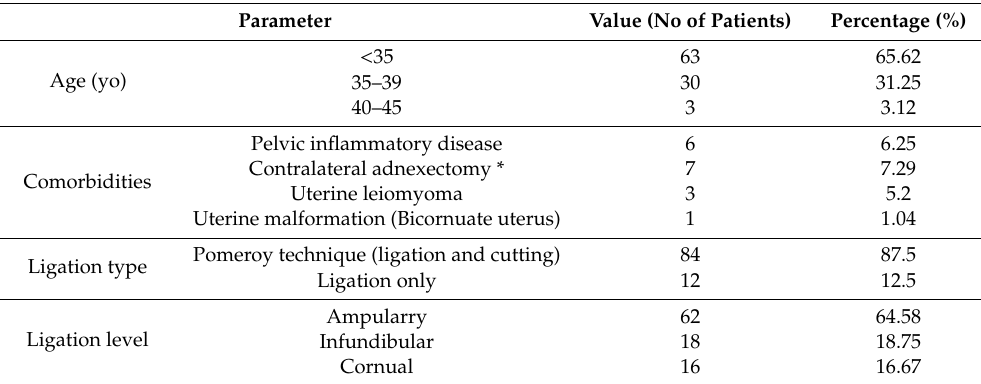
Table 1. Patients’